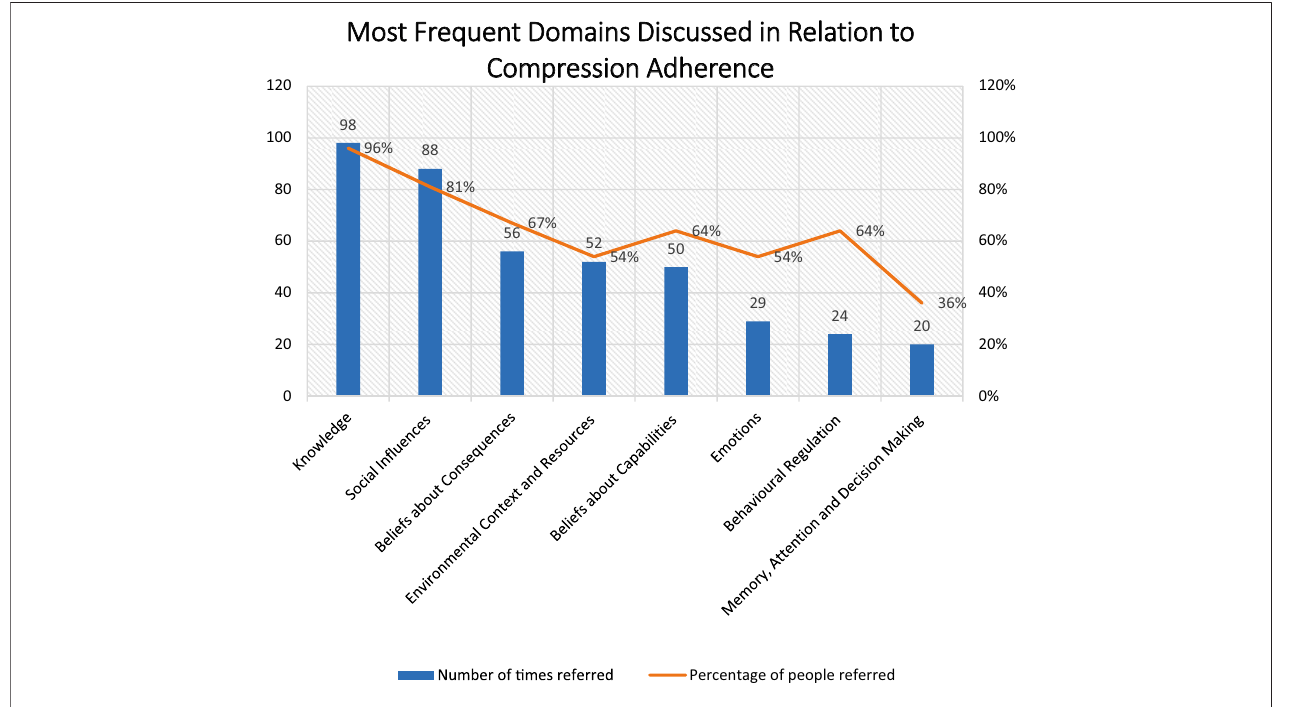
FIGURE 1 | Most frequent domains discussed in relation to compression adherence.